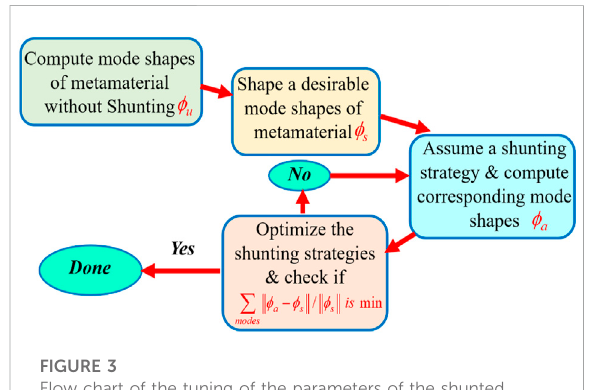
FIGURE 3 Flow chart of the tuning of the parameters of the shunted network and the mode shapes.